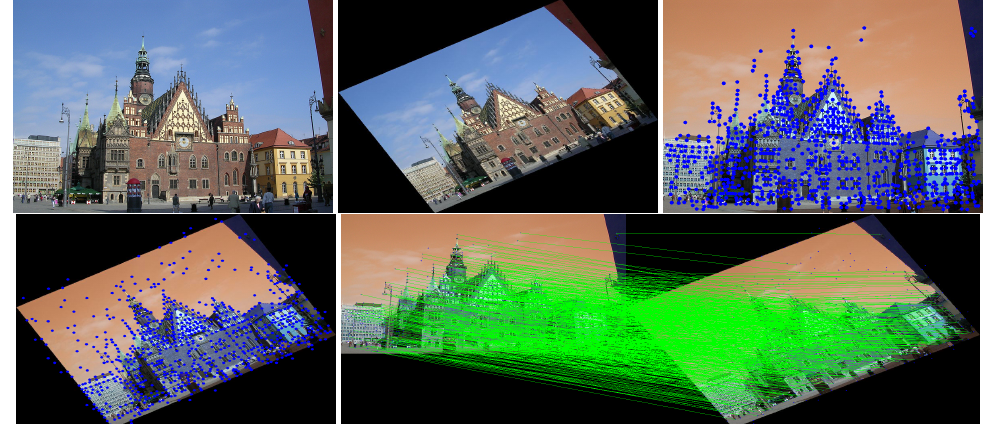
Figure 17. ( Rotate ) Row 1: Left (original image), Middle (attacked images.), Right (resulting point of original image by SuperPoint’s detector). Row 2: Left (resulting point of attacked image by SuperPoint’s detector), Right (the green lines show the correct correspondences after blurring attacks).